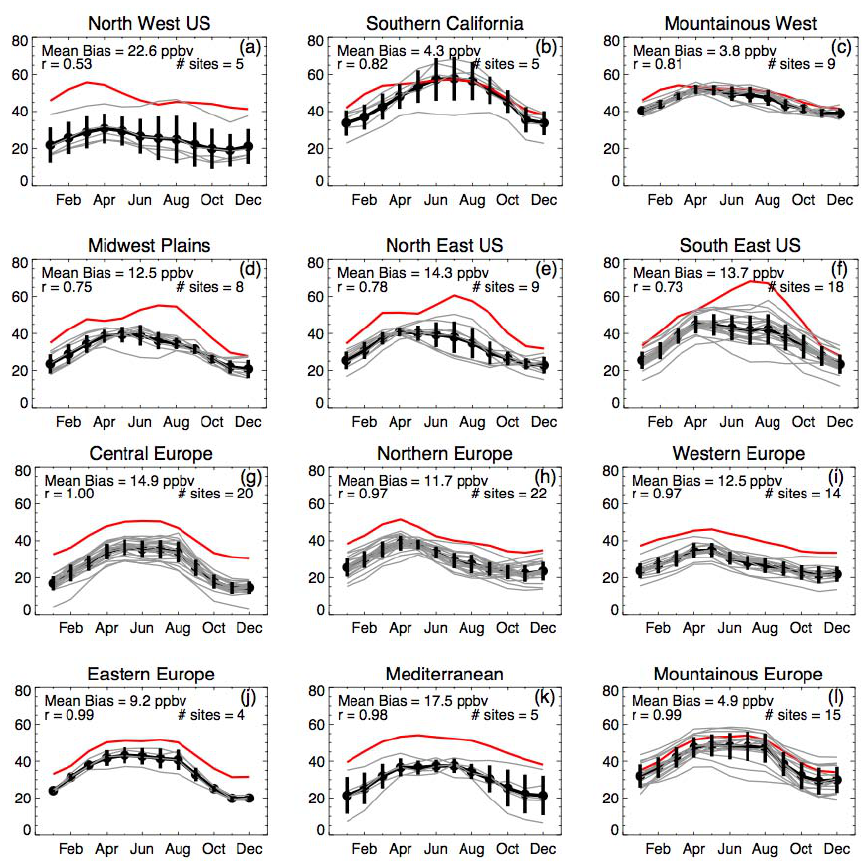
Fig. 1. Comparison of simulated monthly mean surface O 3 in GFDL AM3 “2000” simulation (red line) with measurements from var- ious regions in the United States ( a–f , results from CASTNet, http://www.epa.gov/castnet/) and Europe ( g–l , results from EMEP, http: //www.nilu.no/projects/ccc/emepdata.html). Observed values (black dots) represent the average of climatological monthly mean surface O 3 concentrations for each site (grey lines) within each region (Table S1 in Naik et al., 2013). Vertical black lines denote standard deviation across the